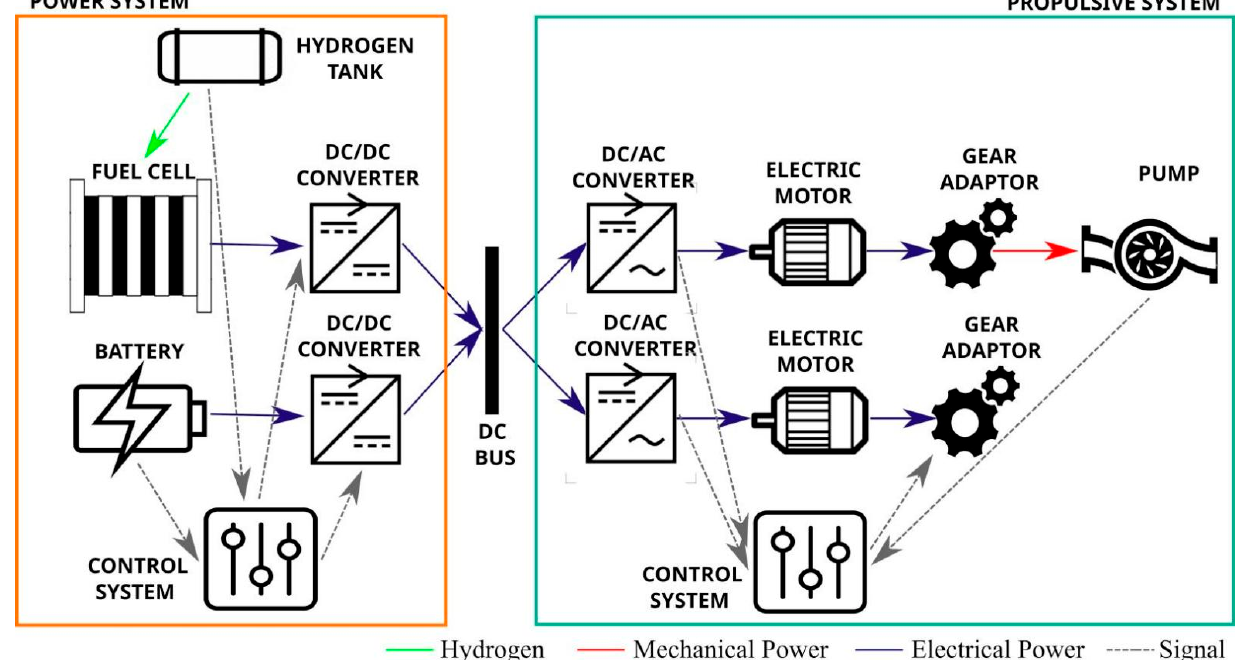
Figure 1. Simplified scheme of the AMV innovative powertrain.